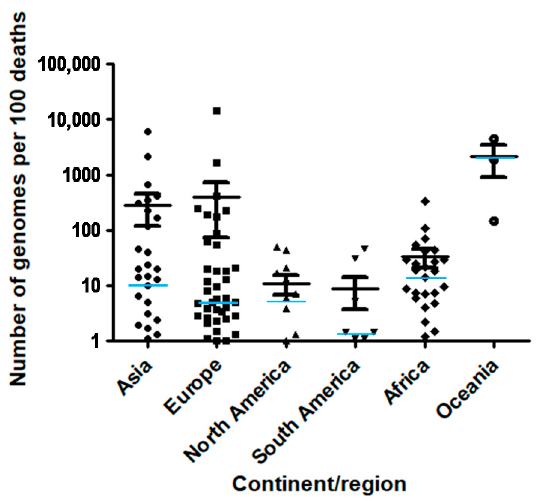
Figure 2. Number of SARS-CoV-2 genomes per 100 SARS-CoV-2-associated deaths according to continent/region. Median value for each region is indicated by a light blue horizontal bar.